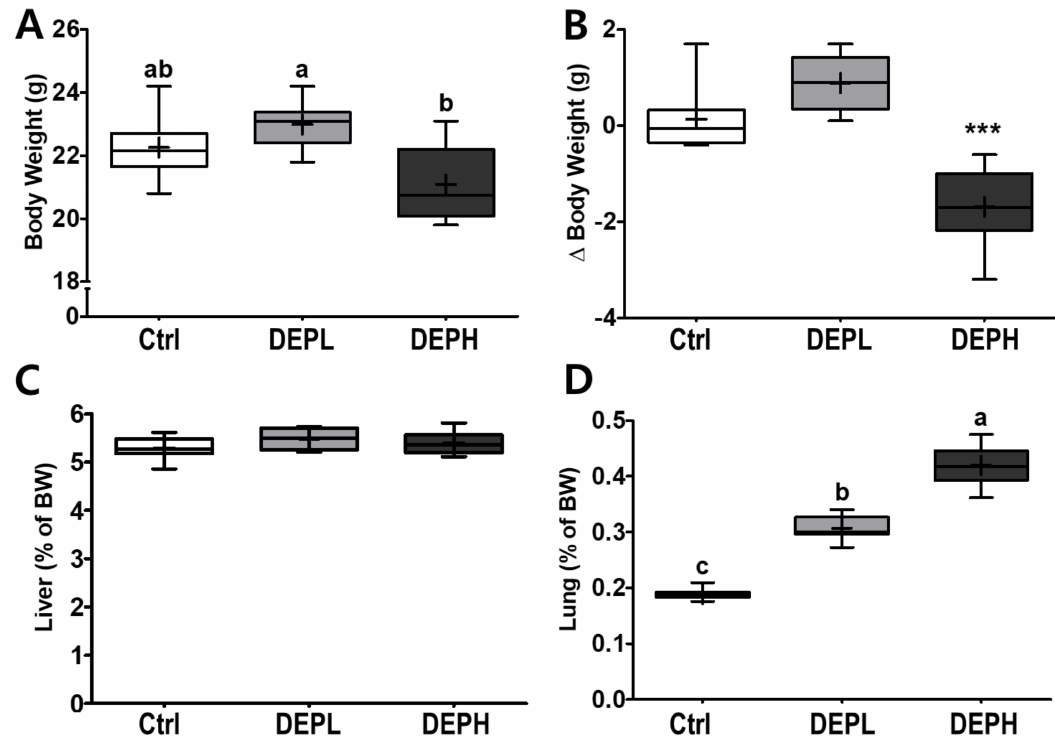
Figure 1. Box-and-whisker plots representing physiological changes in diesel exhaust particles (DEP) exposed mice on ( A ) body weight (BW); ( B ) change of BW (final BW minus initial BW); ( C ) liver weight/BW ratio; and ( D ) lung weight/BW ratio; n = 8 for each group. A one-way ANOVA followed by Tukey’s post-hoc test was performed; labeled means without a common letter differ ( p < 0.05); *** p <